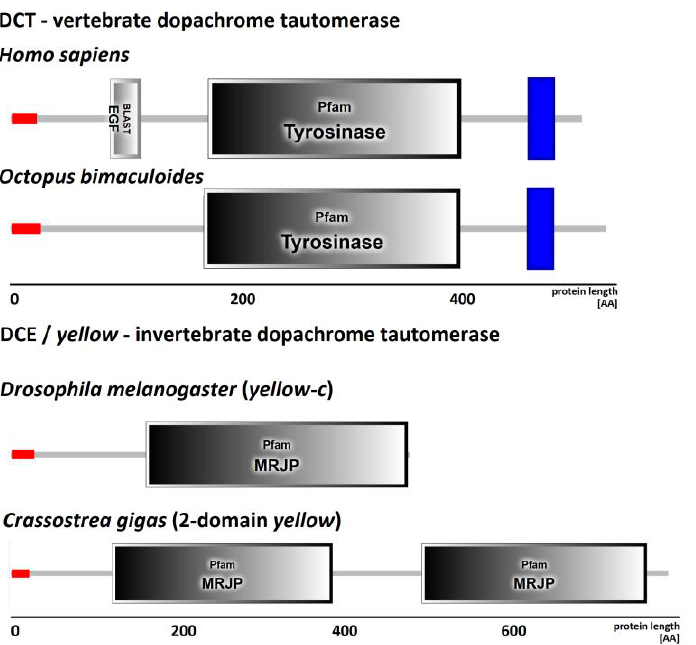
Figure 1. Dopachrome tautomerase (DCT) and Dopachrome converting enzyme (DCE) protein structures showing the conserved domains and motifs found in Homo sapiens and Octopus bimaculoides DCTs as well as in Drosophila melanogaster and Crassostrea gigas DCE/ yellow . Red boxes depict signal peptide regions, blue boxes transmembrane motifs and gray rectangles the conserved PFAM domains (EGF, PF00008; Tyrosinase, PF00264; MRJP, PF03022).